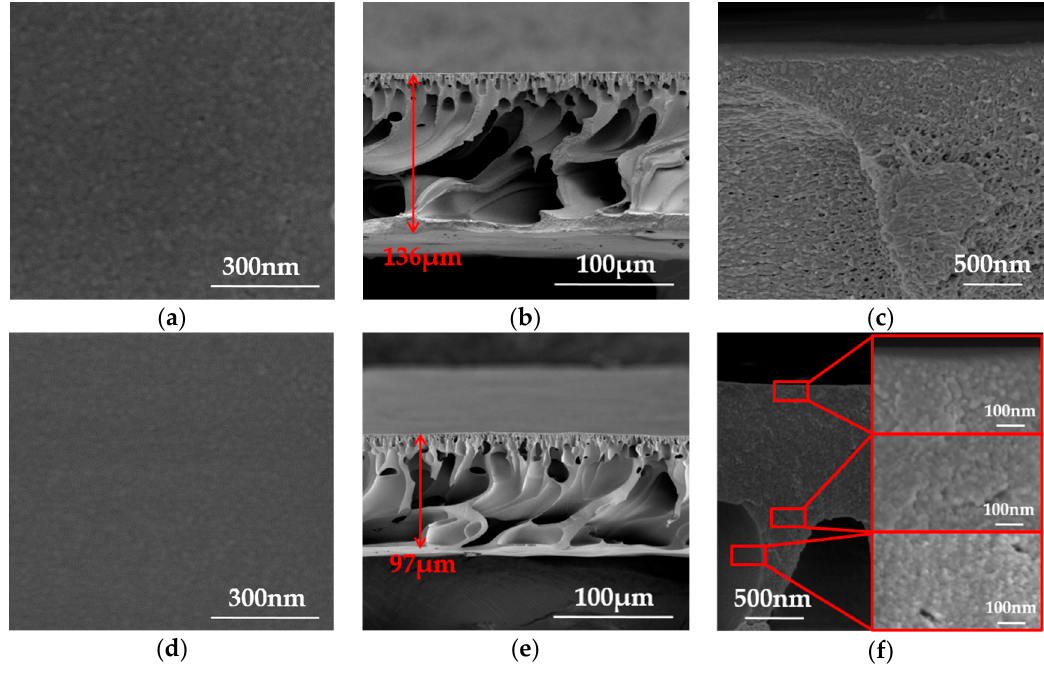
Figure 9. The SEM images of PAN membrane ( a – c ) and CLA-PAN-230 membrane ( d – f ) ( a , d : surface; b , e : cross-sectional; c , f : enlargement of the dense layer).